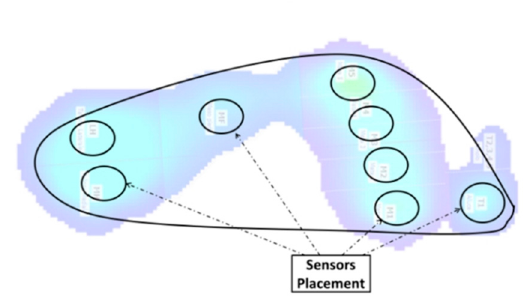
Figure 2. Temperature and pressure sensors